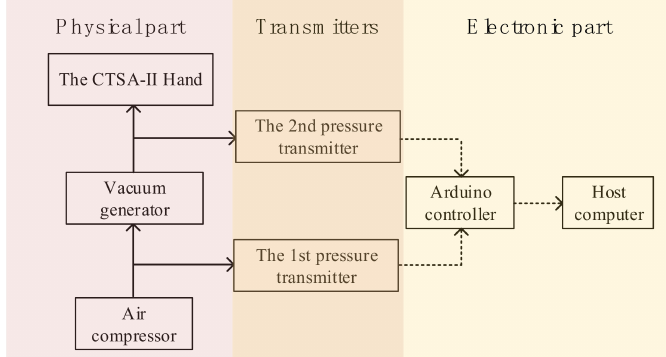
Figure 18. The experimental structure of exploring